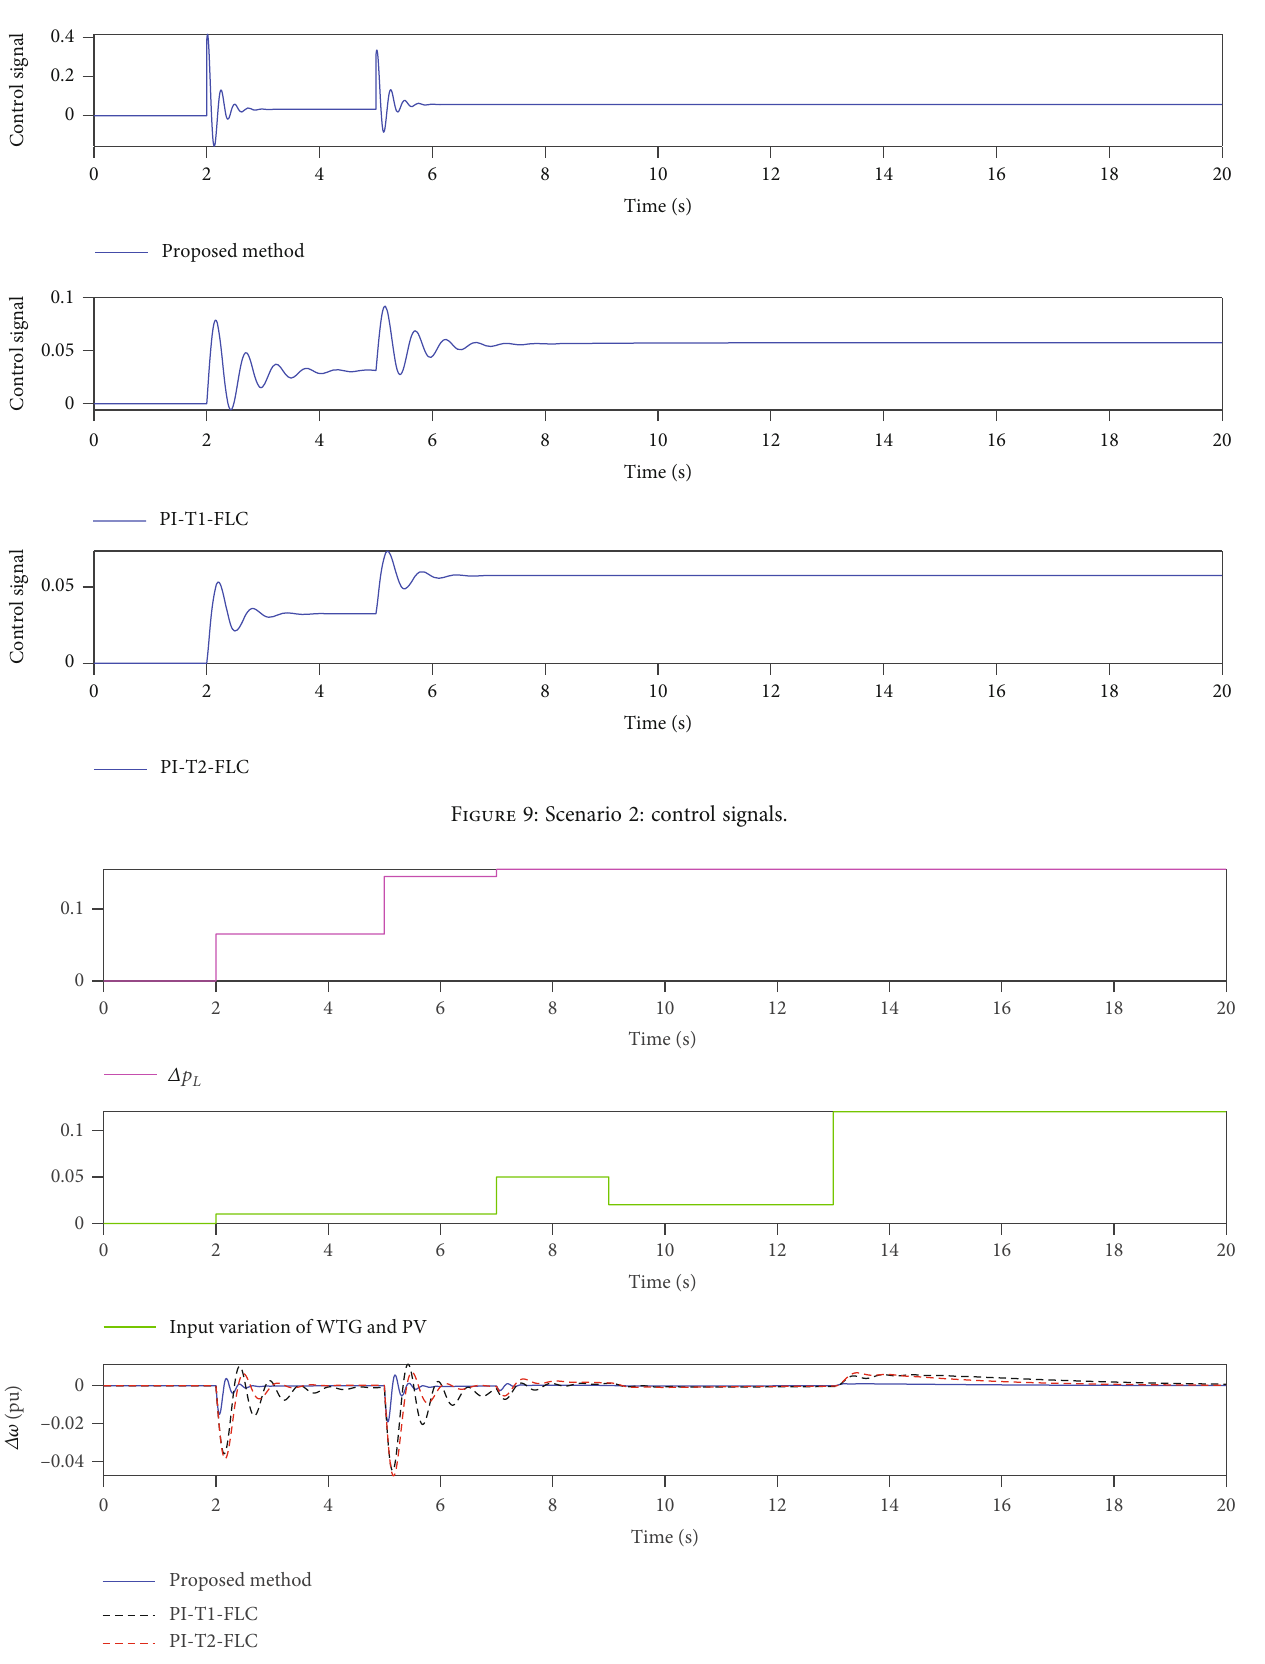
Figure 10: Scenario 3: multiple changes in load and irradiation wind power.